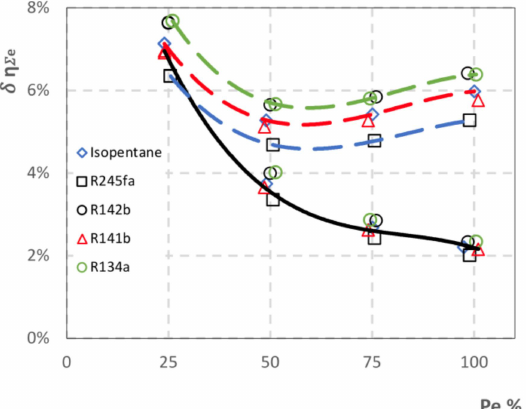
Figure 4. ORC ( a ) energy indicator P gen comparison of strategies G w.fl. = const ( ); G w.fl. = var . ( ); blue line = Dry fluid; red line = Isentropic/Dry fluids; green line = Wet/Isentropic fluids; ( b ) P gen increase with cogeneration cycle with strategy G w.fl. = var .